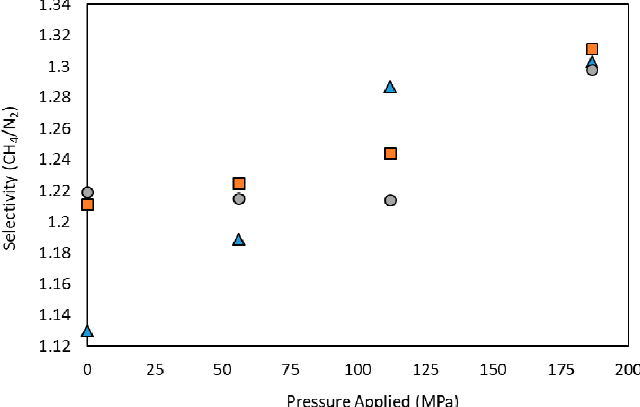
/ N Figure 7. Adsorption CH 4 /N 2 selectivity (mass basis) for each material at different applied pressures, Figure 7. Adsorption CH 4 2 selectivity (mass basis) for each material at di at 298 K and 0.1 MPa of total pressure. Basolite C300 ( (cid:78) ), Basolite F300 ( (cid:4) ) and Basolite A100 ( • ).